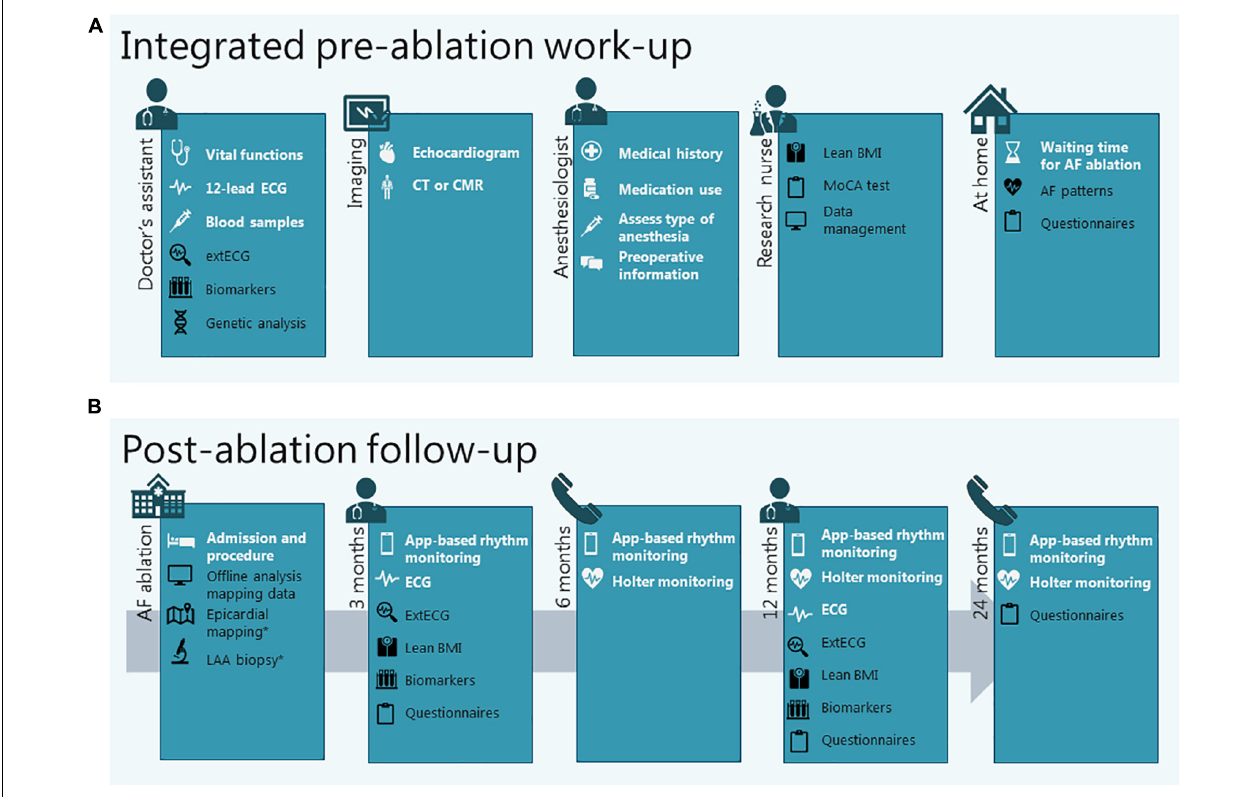
FIGURE 3 | Integration of clinical diagnostics and study procedures in the work-up before (A) and the follow-up after (B) AF ablation. Procedures in white are standard clinical procedures, procedures in black are added for research purposes. ∗ When applicable (in case of epicardial or hybrid ablation). AF, atrial fibrillation; BMI, body mass index; CMR, cardiac magnetic resonance imaging; CT, computed tomography; ECG, electrocardiogram; extECG, extended surface electrocardiogram; LAA, left atrial appendage; MoCa, Montreal Cognitive